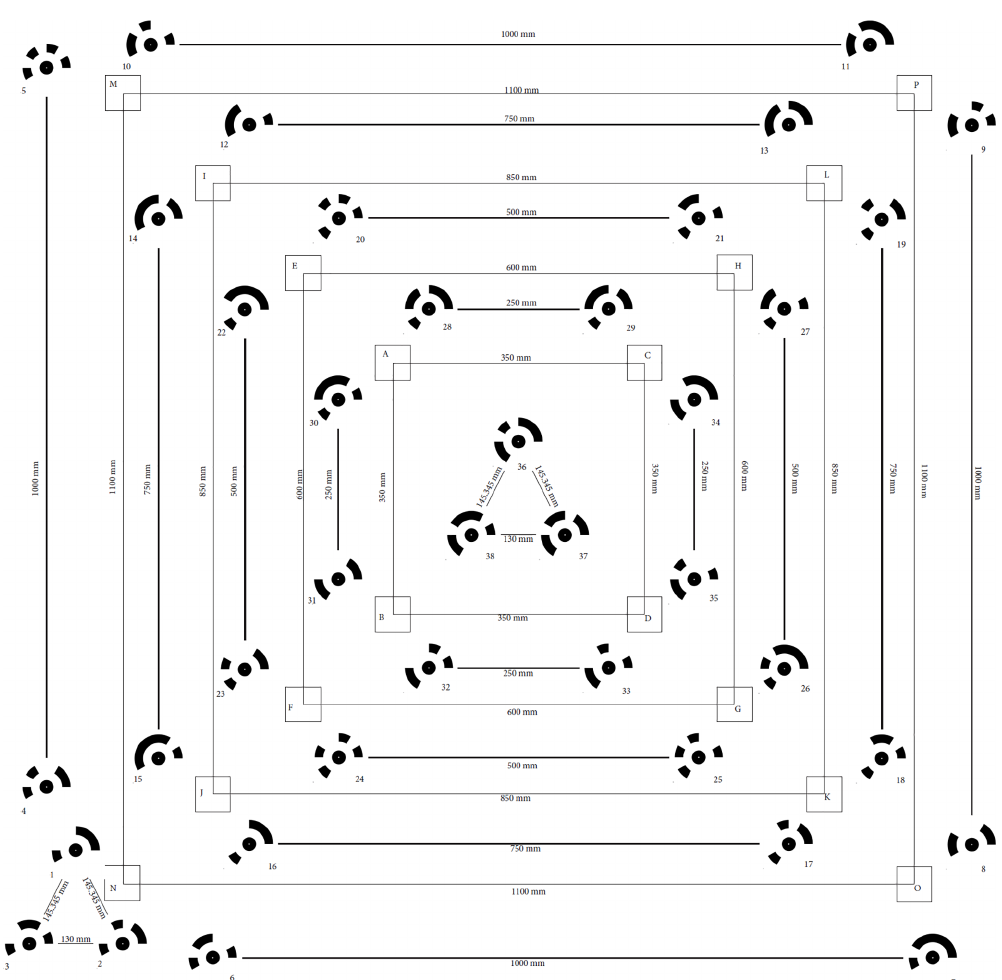
Figure 3. Error evaluation chart (1 . 4 × 1 . 4m). Coded scale bars are horizontal checkpoints. Wooden blocks (small squares) at each vertex of bigger squares are vertical checkpoints. Two triangle-coded control targets were used to georeference